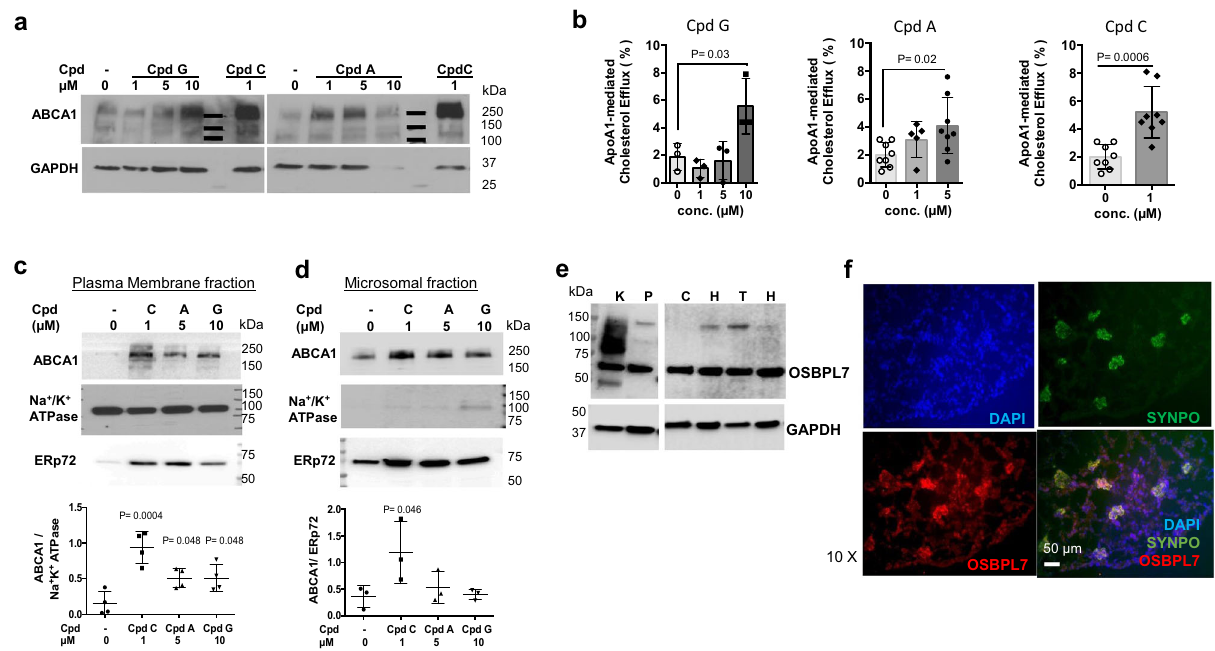
Fig. 5 Compound treatment increases ABCA1-mediated cholesterol ef fl ux in human podocytes. a Representative ABCA1 and GAPDH Western blots from podocytes treated with Cpd G (left), Cpd A (right), and the LXR agonist Cpd C, at the concentrations indicated (full western blots shown in Supplementary Fig. 4). b apoAI-mediated cholesterol ef fl ux in podocytes treated with Cpd G (left), Cpd A (middle) and Cpd C (right) at the concentrations indicated. Data expressed as the mean ± SD. Treatments with Cpd G or Cpd A were compared to vehicle using one-way ANOVA, followed by Dunnet ’ s test. P = 0.03 for Cpd G at 10 µ M, n = 3, F(3, 8) = 6.9; P = 0.02. for Cpd A, n = 8, F(2, 18) = 3.9; P > 0.05 for other concentrations. Cpd C and vehicle were